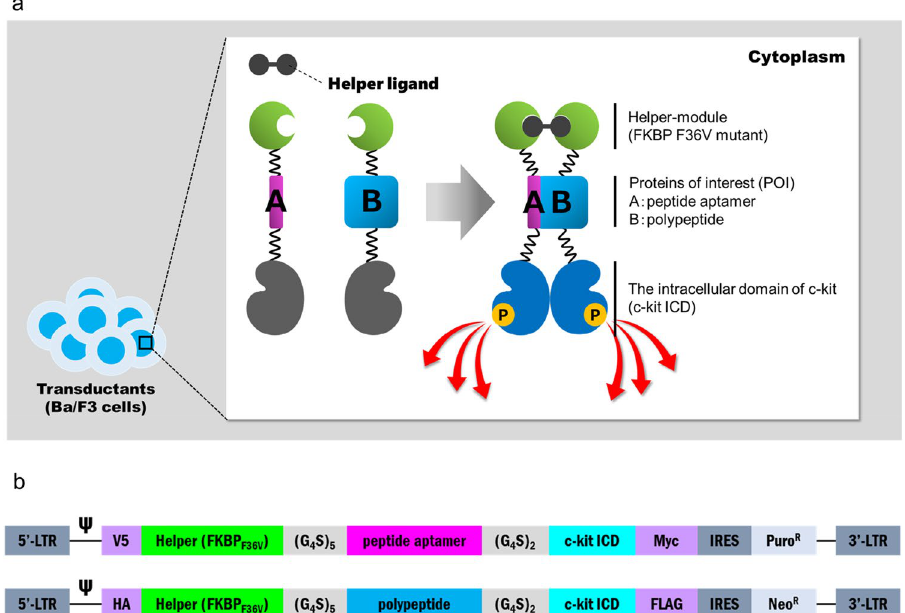
or polypeptide (B)], and the c-kit intracellular domain (c-kit ICD). The helper ligand supports the formation of stable complexes. Flexible linkers (G 4 S) 5 and (G 4 S) 2 were employed to link the helper module/POI and POI/c-kit ICD, respectively. ( b ) The architectures of retroviral vectors. LTR long terminal repeat. Psi (Ψ); packaging signal. V5/Myc and HA/FLAG; tag peptides. IRES internal ribosome entry site. Puro R /Neo R ; drug resistance gene against